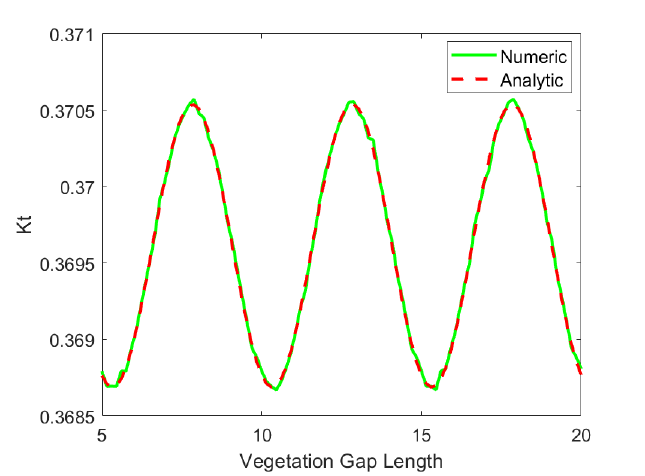
Figure 9. K t Oscillates throughout Different Vegetation